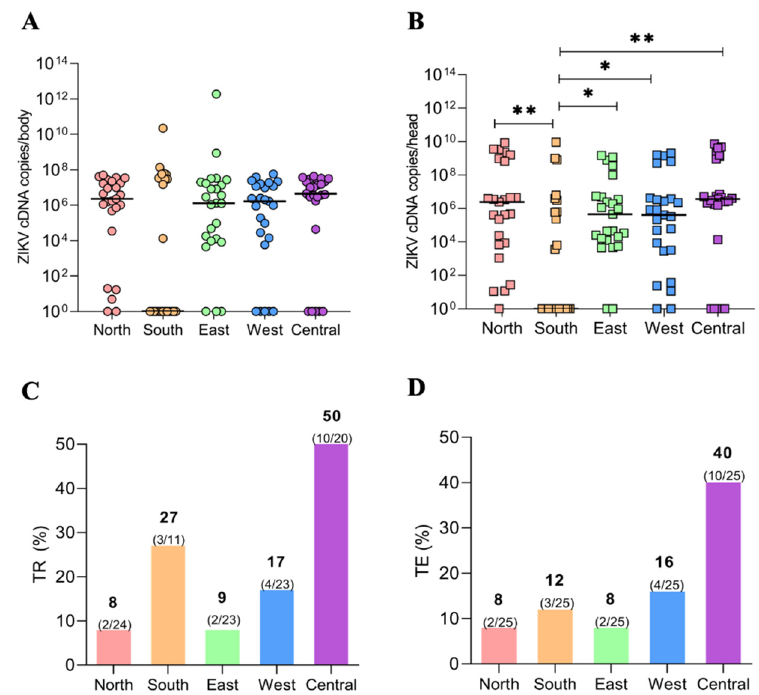
Figure 2. ZIKV viral loads (VLs) per body ( A ) and head/salivary gland (B ) in Ae. aegypti populations from the five districts of Manaus. The VLs were measured as cDNA copies by qPCR at 14 days post-infection. Transmission rate ( C ) and transmission efficiency ( D ) of the 5 Ae. aegypti populations from Manaus for ZIKV at 14 days post-infection. The p values 0.05 and 0.01 are summarized with one (*) and two (**) asterisks, respectively.